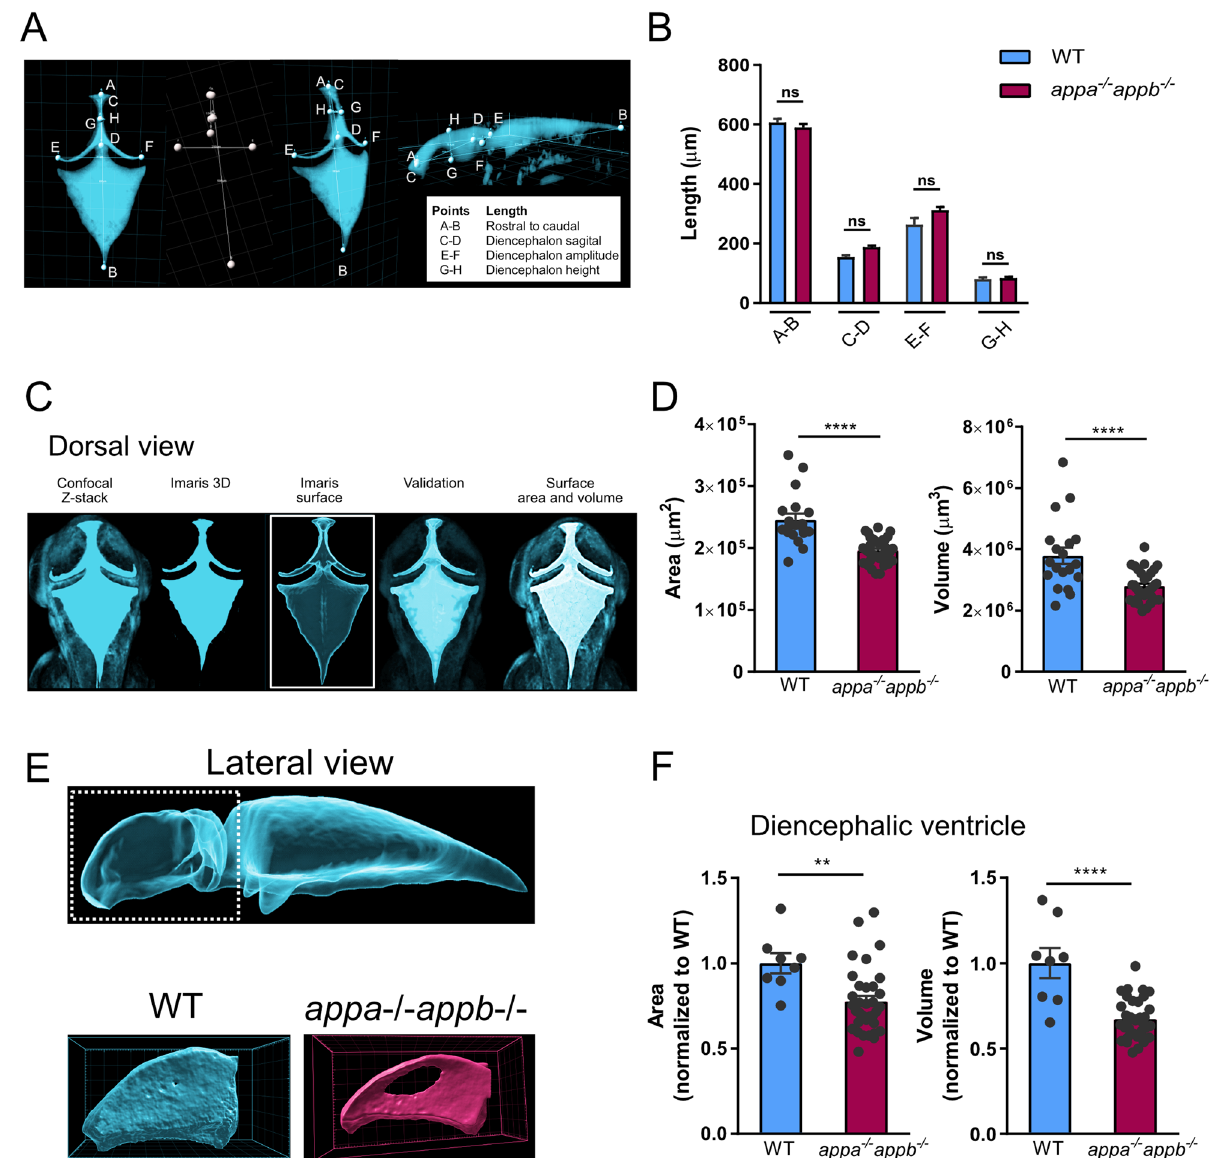
Figure 9. The appa −/− appb −/− 2 dpf larvae zebrafish exhibit smaller brain ventricle. Dorsal 3D surface rending of confocal stacks taken from brain ventricles of dextran injected 2 dpf zebrafish larvae ( A ). Quantification of total ventricle surface area and volume show that both are decreased in appa -/- appb -/- larvae ( B ). Lateral 3D surface rending of confocal stacks from brain ventricles of dextran injected 2 dpf zebrafish larvae with close up on diencephalic ventricle ( C ). Quantification of surface area and volume of the diencephalic ventricle in WT and appa -/- appb -/- larvae ( D ). Measurement of gross ventricle morphology at 2dpf WT and appa -/- appb -/- larvae as the length ( E ). Distance between rostral to caudal, diencephalon ventricle sagittal length, amplitude and height show no significant difference in mutants ( F ). Data are reported as mean ± SEM. ** ρ < 0.01, **** ρ < 0.001. n: ( B ) WT = 19, appa -/- appb -/- = 34, ( D ) WT = 8, appa -/- appb -/- = 34, ( F ) WT = 5, appa -/- appb -/- =